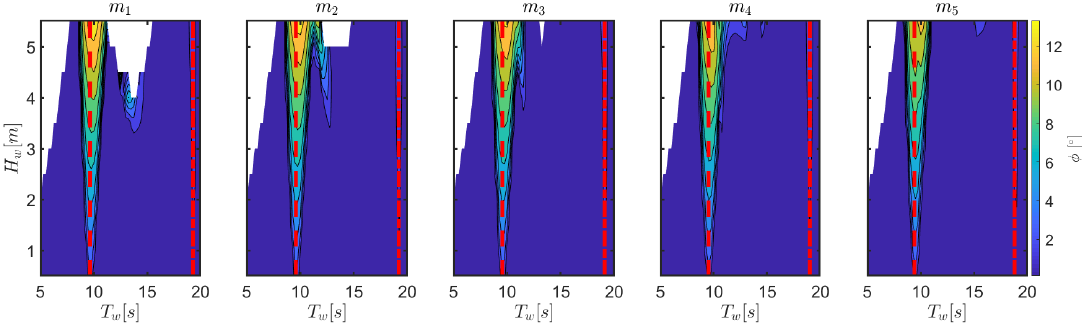
Figure 12. Amplitude of the roll response for different mooring configurations, as tabulated in Table 3. For a fair comparison, the same color bar applies to all plots. The dashed and dash-dotted red lines correspond to T w = 1 T n ,5 and T w = T n ,5 , respectively. 2